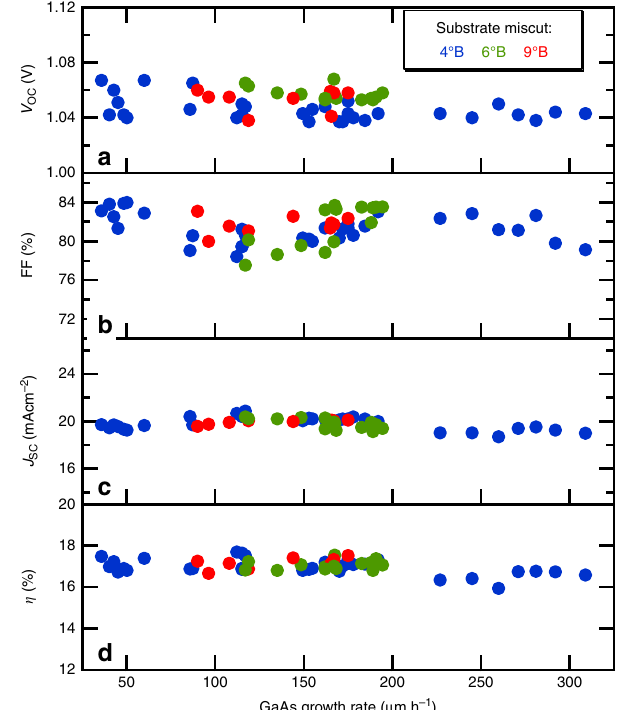
Fig. 3 Performance of GaAs solar cells grown at growth rates from 35 to 309 µ m h − 1 . a – d Open-circuit voltage ( V OC ), fi ll factor (FF), short-circuit current ( J SC ) and ef fi ciency ( η ), respectively, of solar cells grown at varying growth rates on different miscut (4°B, 6°B, and 9°B) substrates. All measurements were without antire fl ection coating and under the AM1.5 G illumination